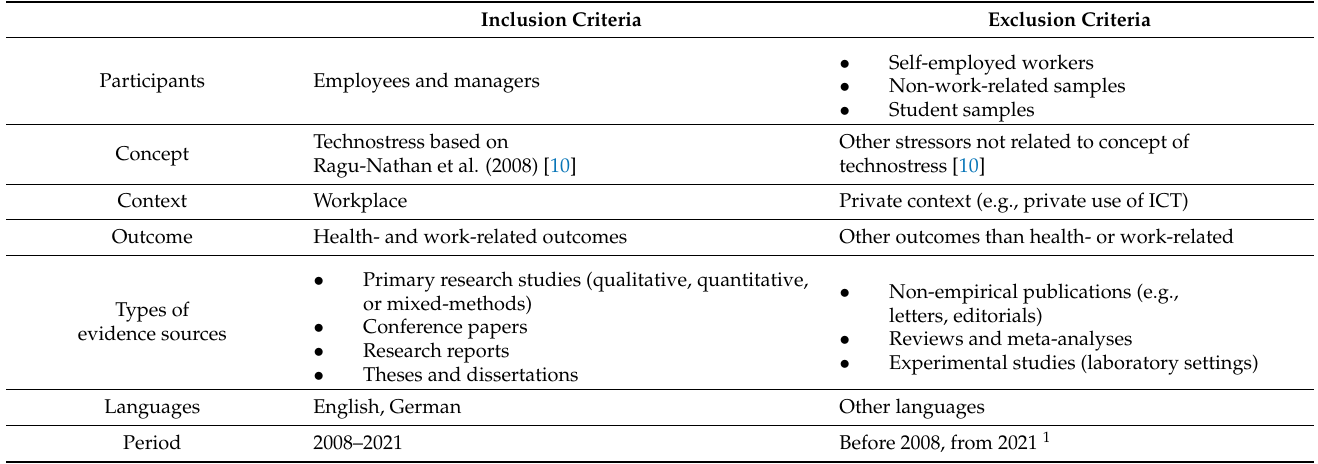
Table 1. Eligibility